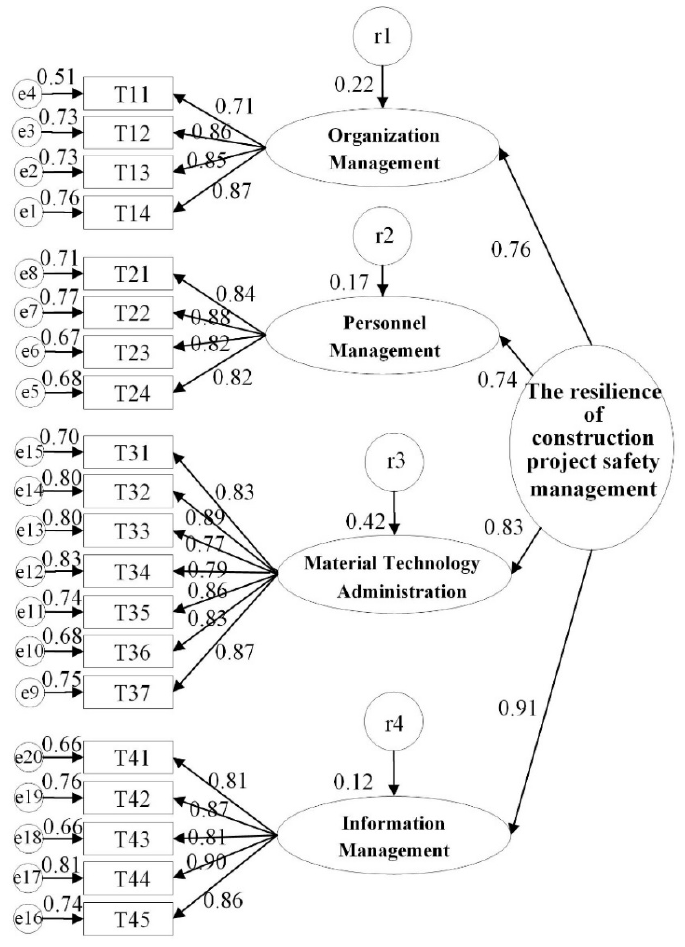
Figure 4. Road map for the SEM model. Table 7. Fit index calculation.